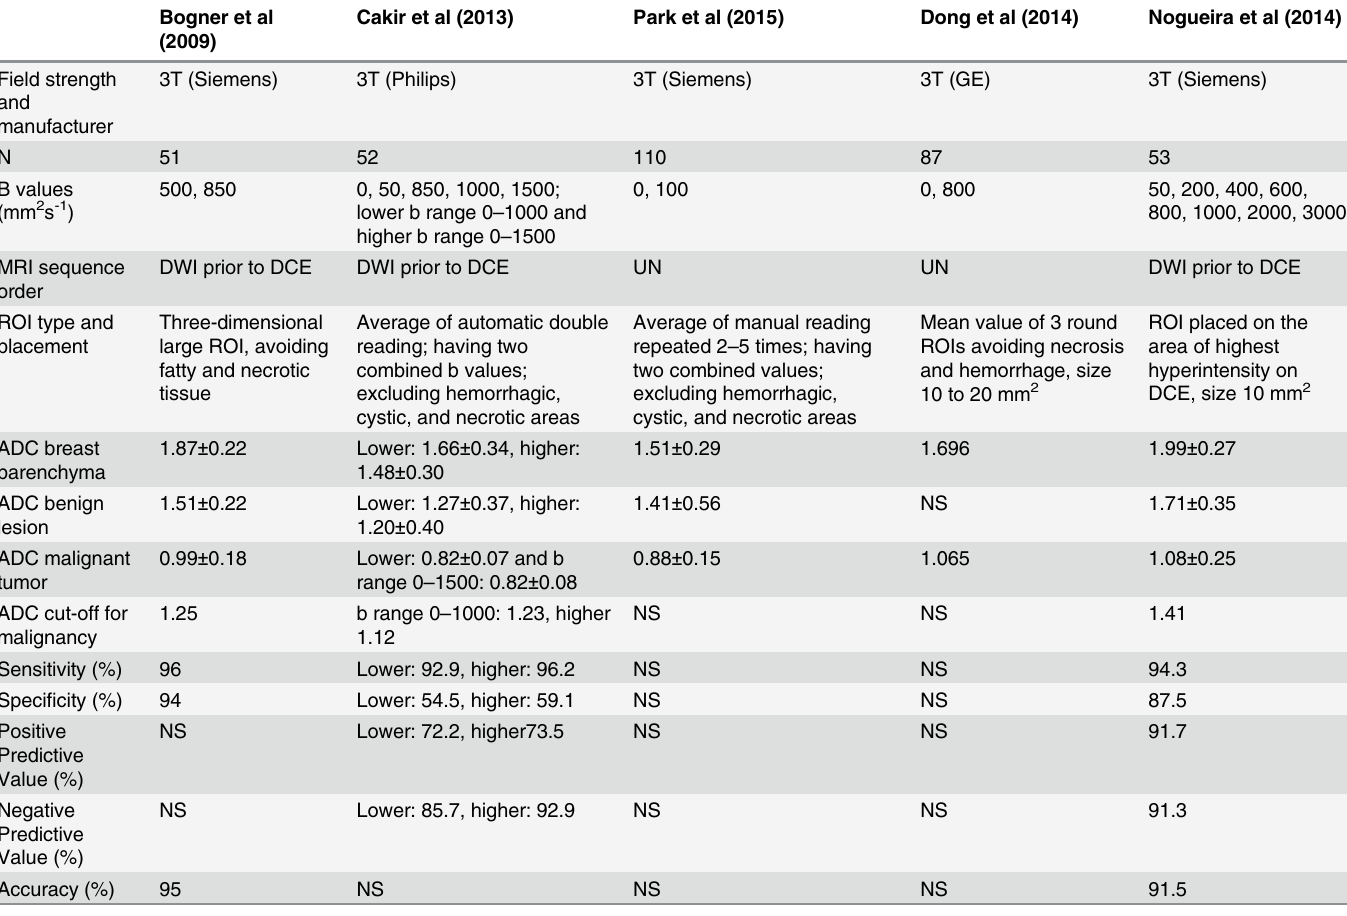
Table 3. Mean apparent diffusion coefficient (ADC) values (× 10 − 3 mm 2 s -1 ) of 3.0-Tesla using MRI from normal parenchyma, benign lesions, and malignant lesions, and ADC values ’ utility in tumor characterization. A review of the